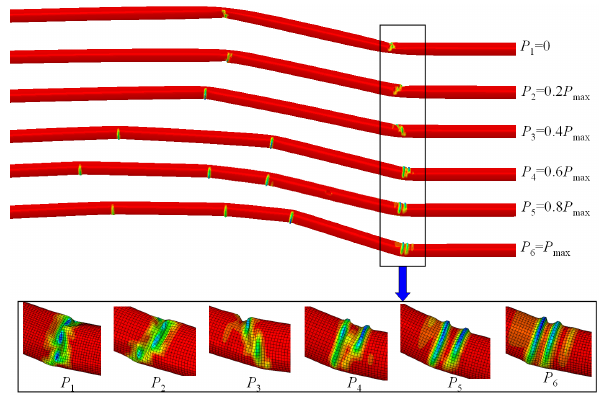
Figure 9. Buckling behaviors of the buried pipeline under different internal